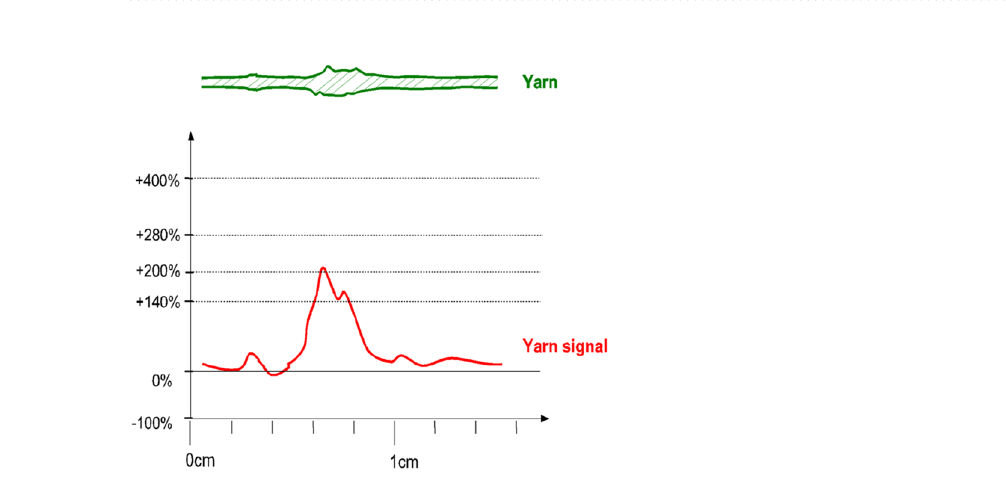
Figure 12. A nep in a yarn and the corresponding yarn signal in the measuring slot.